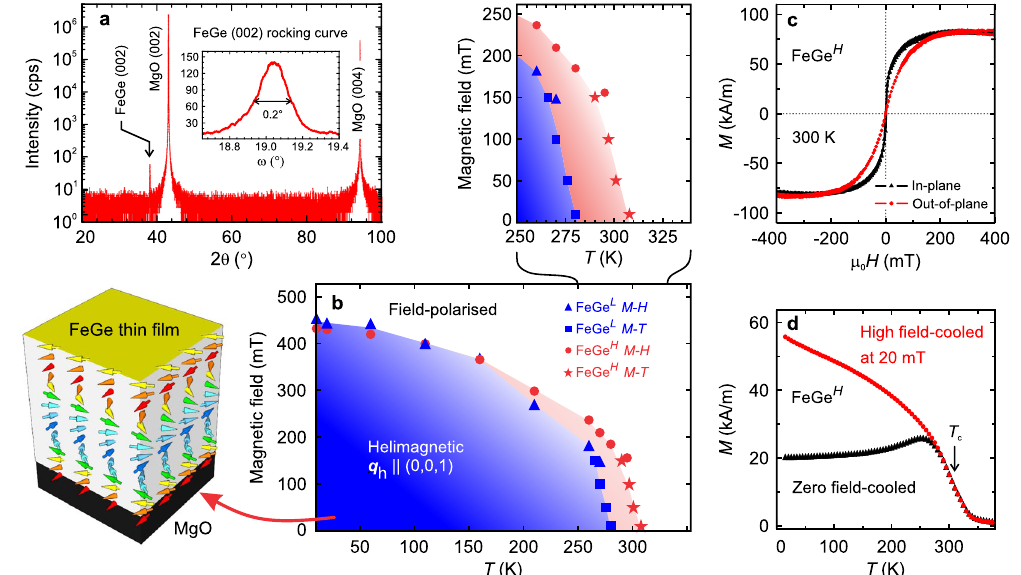
Figure 1. Structural and magnetic study of ~200-nm-thick FeGe films. ( a ) Out-of-plane x-ray diffraction showing a preferred (002) orientation of the FeGe film. The inset shows the rocking curve of the FeGe (002) peak. ( b ) Magnetic phase diagrams for FeGe L and FeGe H films. The blue and red shaded areas represent the phase space of the helimagnetic phase for the FeGe L and FeGe H films, respectively. A close-up of the phase space around the transition temperature is shown above. ( c ) Room-temperature magnetisation measurement with the field applied both in-plane and out-of-plane. ( d ) Temperature dependence of the magnetisation. The zero field- cooled curve is obtained by first cooling the sample in zero field from 300 K down to 10 K before measuring in an out-of-plane field of 20 mT while heating. The high field-cooled data are obtained by first cooling in an applied field of 500 mT down to 10 K, before measuring in an out-of-plane field of 20 mT while